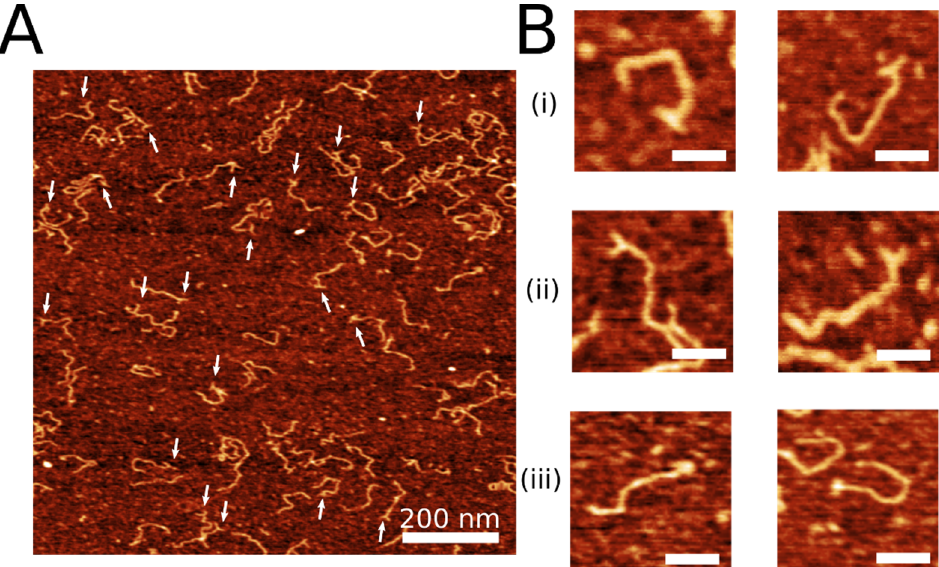
Figure 2. 3WJ label on free DNA. ( A ) Representative AFM image of 3WJ label on DNA. White arrows point to label. Scale bar is 200 nm. ( B ) Snapshots of DNA with open “T” label conformation ( i ), bent “Y” label conformation ( ii ), and condensed “bulge” label conformation ( iii ). The AFM images are taken in air. Scale bars indicate 50 nm.